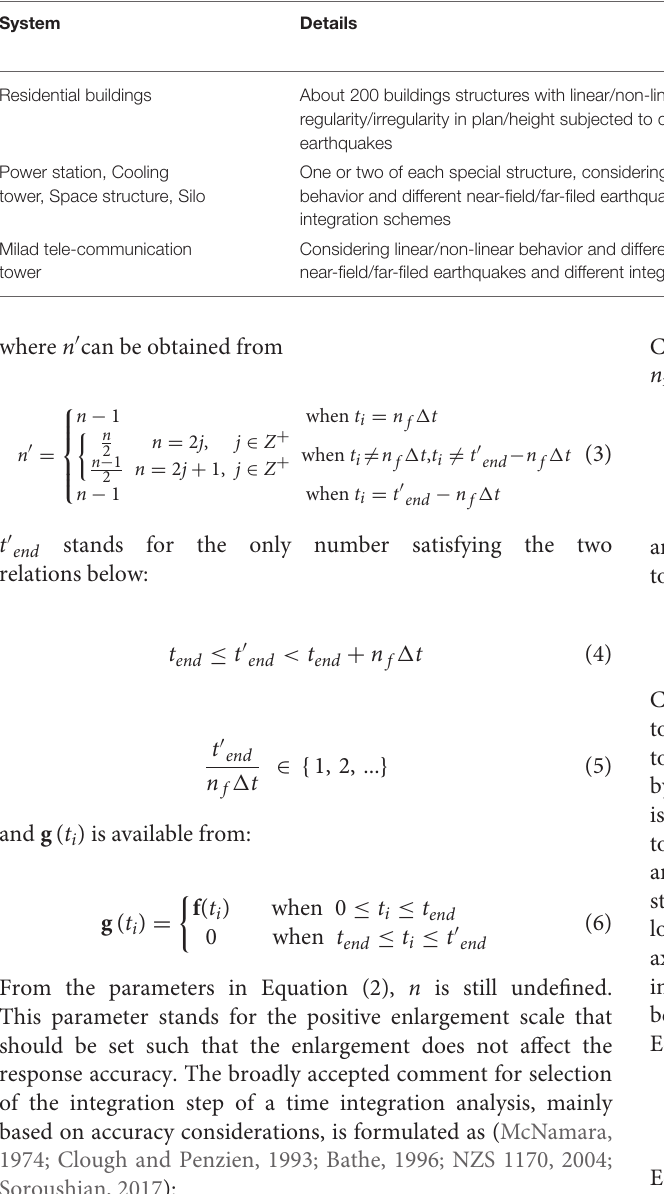
TABLE 1 | A brief report of the tests carried out on the technique proposed by Soroushian